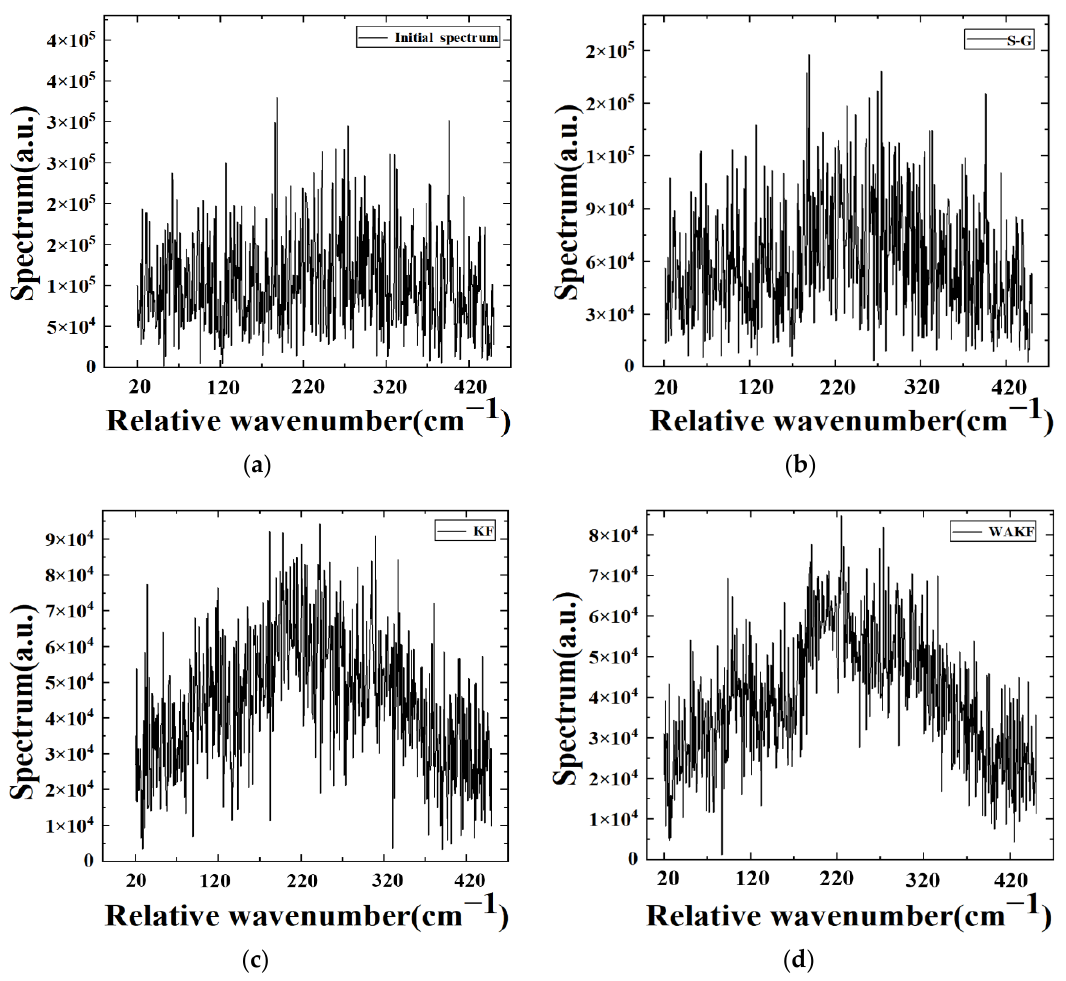
Figure 8. The spectra before and after the denoising algorithms of the 747th pixel at a sampling frequency of 80 MHz. ( a ) Initial spectrum, denoised spectra using the ( b ) S-G, the ( c ) KF and ( d ) WAKF algorithms.